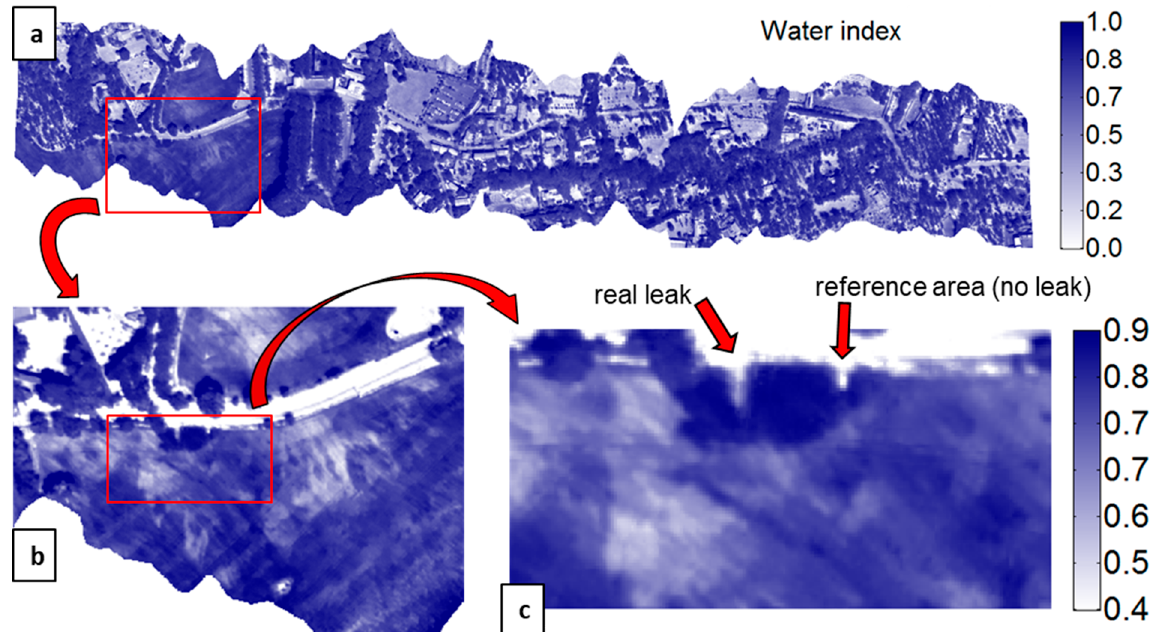
Figure 8. Water Index over the Le Tholonet area obtained on 21 April 2017. ( a ) General view corresponding to a single flight line. ( b ) Close-up of the WI map showing the artificial leak in a wheat field, south of the road in white. ( c ) Still closer view of the WI map showing two strips of bare soil, one over the leaking pipe (on the left) and the other one acting as reference (bare soil in the wheat field, without leak). The Water Index reaches highest values in an area surrounding the leak and diffuses east to the reference area (dark-blue half-disk).